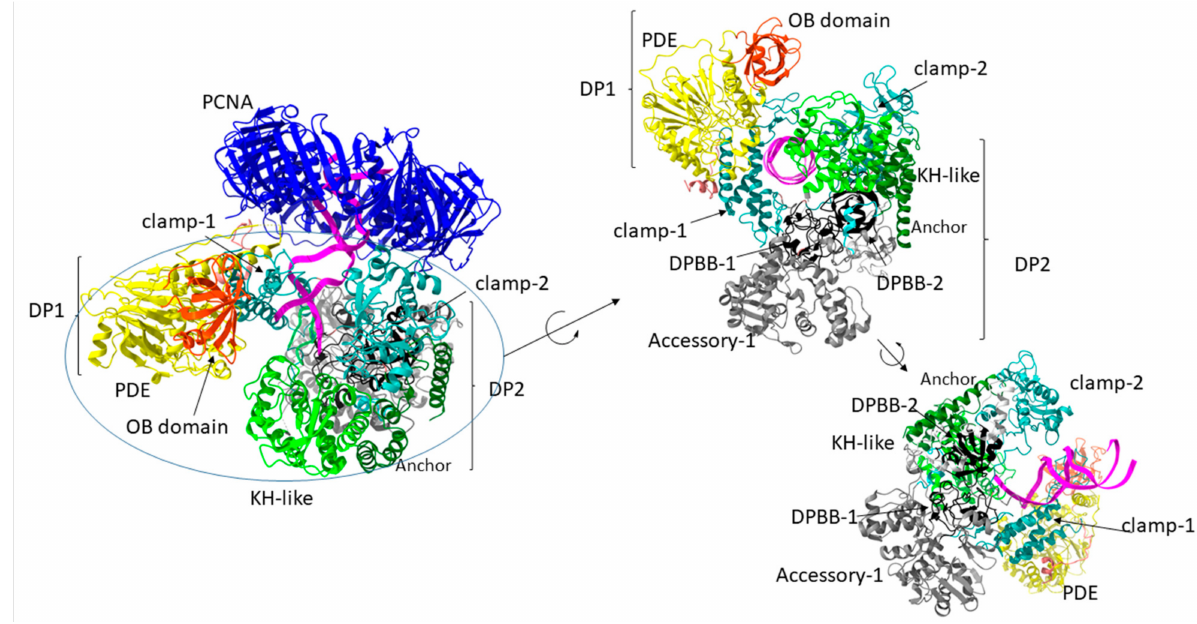
Figure 6. The cryo-EM structure of the DNA-bound Pol D-PCNA processive complex (PDB ID 6t8h). PCNA trimer is colored blue. Overview of Pol D domain organization: DP1 includes OB (orange) and PDE (yellow); DP2 includes DPBB-1 and DPBB-2 (black), clamp-1 and clamp-2 domains (cyan), KH-like (green)—which is connected to the Anchor domain (dark green)—and Accessory-1 and Accessory-2 domains